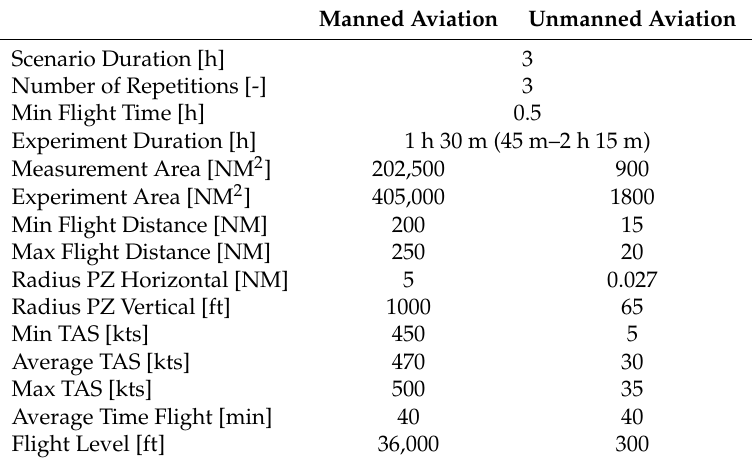
Table 9. Properties of the manned and unmanned aviation scenarios used in simulation. Manned Aviation Unmanned